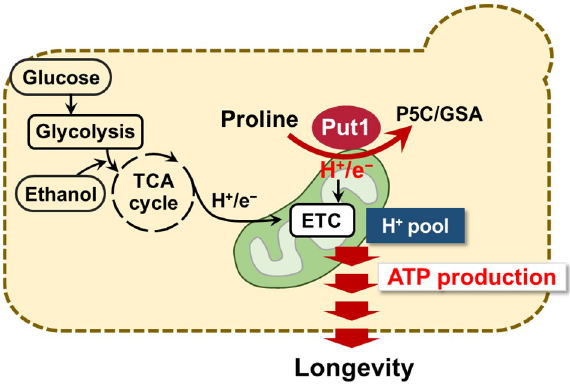
Figure 6. Schematic model of longevity regulation by proline oxidation. In the absence of principal energy sources, such as glucose and ethanol, yeast cells start to utilize proline as an energy source via the Put1-catylatic reaction. This reaction results in the generation of electrons which are donated to ETC, which generates ATP. Such a mechanism may contribute to longevity.